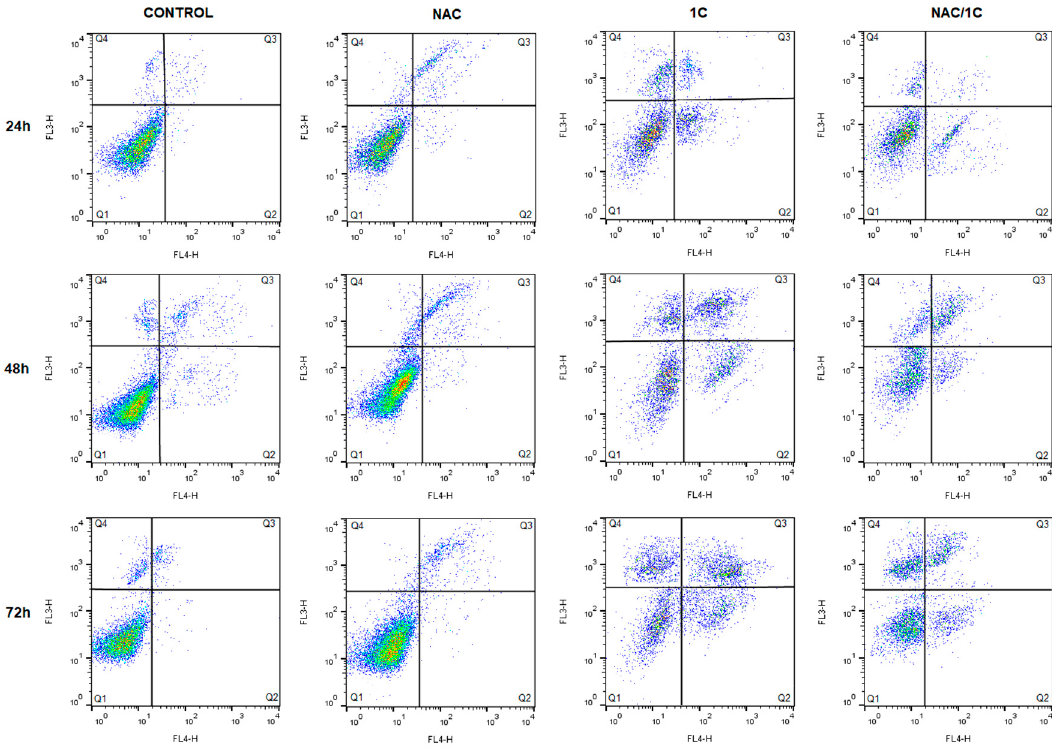
Figure 6. Representative dot-blot diagrams of annexin V / PI staining in HCT116 cells after treatment with NAC, 1C, and NAC / 1C. Table 4. Externalization of phosphatidylserine after treatment with NAC, 1C, and NAC/1C.